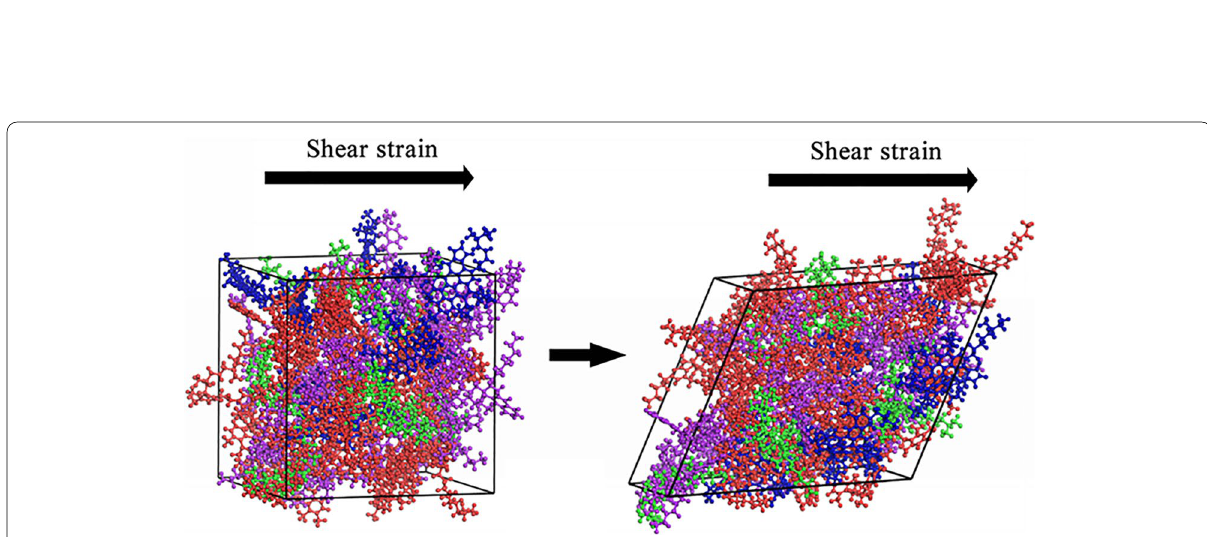
Fig. 6 MD Simulation Box with Initial and Shearing Conditions for Viscosity Calculations (asphaltene, resin, aromatic, and saturate are represented as blue, purple, red, and green,